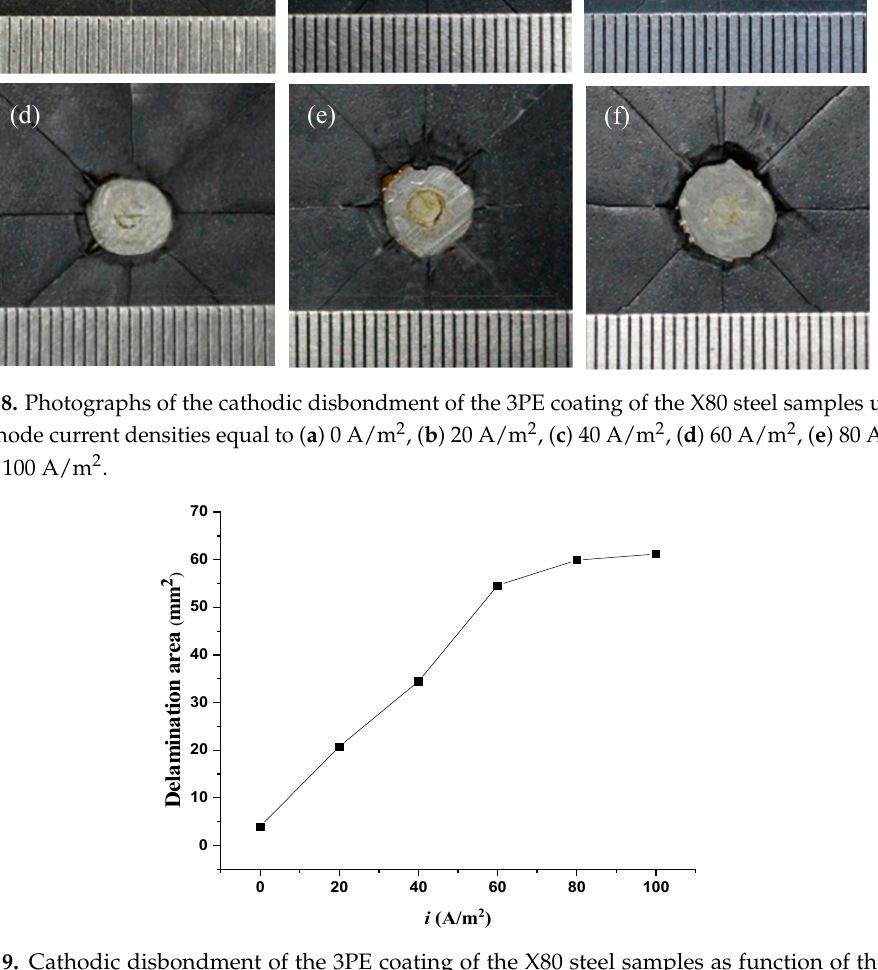
Figure 10. A schematic of the corrosion and organic cathodic disbondment mechanism of the pipeline under the DC stray current conditions. Under a DC stray current, the iron in the anode region generates Fe 2+ through the electrolysis reaction (see Figure 10a), which then reacts with H 2 O and O 2 to be further oxidized into Fe 2 O 3 (see Figure 10b) and deposited in the anode region. The damage point is rapidly covered by the corrosion product as the reaction continues, which causes the anode reaction to spread to the surrounding areas. Due to the electrolysis of the direct current, the corrosion pit will expand in both directions at the point of damage of the coating. Longitudinal expansion results in thinning of the tube wall, manifesting as corrosion perforation. Lateral expansion causes the metal matrix under the coating to dissolve, manifesting as anode destruction of the coating. ORR and dominating HER occur in the stray current cathode region, producing H 2 and OH − ions. Driven by the electrostatic forces, H 2 and OH − migrate between the interface of the organic coating and the metal substrate forming bubbles and an alkaline environment that weaken the adhesion between the coating and the metal substrate and eventually lead to the cathodic disbondment of the coating.